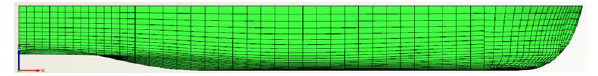
Figure 3. Discretized demihull of the Stavanger demonstrator.